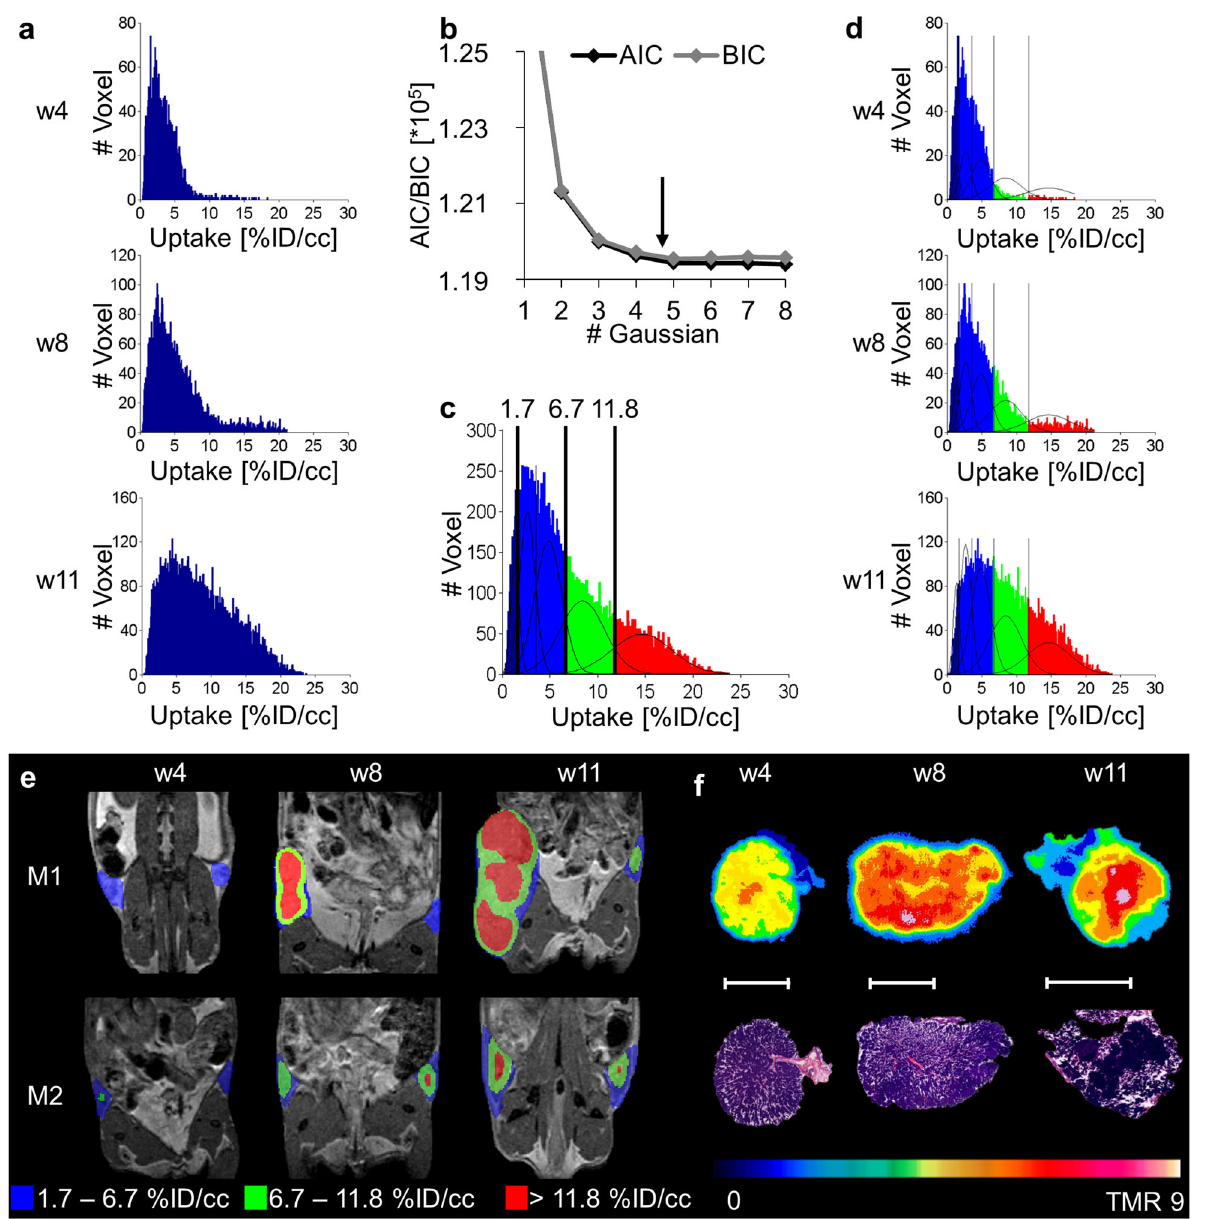
Fig. 1 GMM analysis of [ 18 F]FDG over time correlates with different tumor stages. a Summed histograms of all analyzed lesions of the single time points (w4: n = 16; w8: n = 15; w11: n = 13). Due to spillover effects from surrounding tissues (e.g., bladder), some lesions were excluded from the analysis. The three histograms were summed, and GMM analysis was performed on the summed data of all time points. b AIC and BIC for different numbers of Gaussian distributions, reaching its minimum at a sum of 5 Gaussian distributions. c Calculated thresholds from the 5 Gaussian mixture model were transferred to the summed histogram to separate the populations. d Applying the thresholds to the single time points demonstrates the appearance of the low uptake population in blue (< 6.7%ID/cc), the moderate uptake population in green (6.7 – 11.8%ID/cc), and the highest uptake population in red (> 11.8%ID/cc) for different time points. e Parametric maps of the lesions of two representative mice con fi rm the appearance of the increased uptake populations (green and red) during